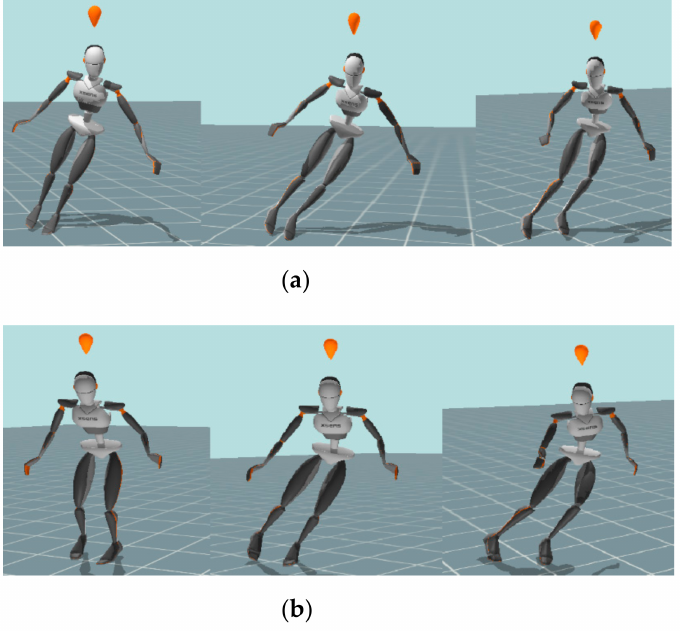
Figure 1. ( a ) Kinogram of a parallel turn (PT) from the first to the third phase of the turn. ( b ) Kinogram of a short turn (ST) from the first to the thirdphase of the